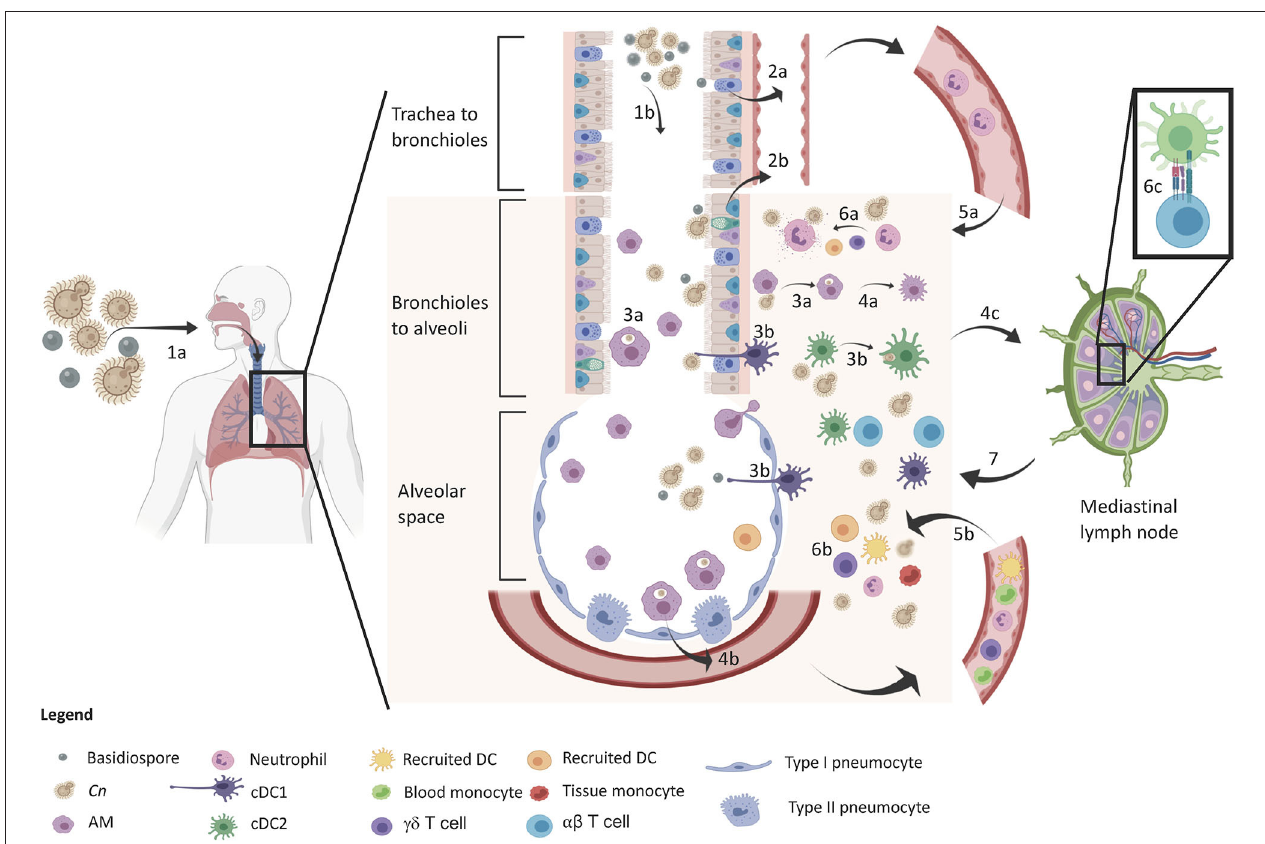
FIGURE 1 | Protective immune response in the lung upon inhalation of C. neoformans . The sequence of events is denoted in the diagram. The yeast and basidiospores are inhaled (1a) and travel down the airways passing through the trachea to the bronchioles (1b) and further down to the alveolar spaces. Upper respiratory epithelia sense the spores (2a) and lower respiratory epithelium sense spores and encapsulated propagules (2b), which release IL-8 for early neutrophil recruitment. Macrophages (3a) and DCs (3b) phagocytose Cn in both the airways and lung tissue leading to M1 macrophage polarization (4a) and cytokine release (GM-CSF and MCP-1) for inflammatory cell recruitment (4b). DCs mature and migrate to the lung draining lymph node (4c) for induction of adaptive immunity. At this time, neutrophil (5a) and inflammatory cells (5b) infiltrate into the lung tissue for increased host defense against Cn . Neutrophils kill Cn via degranulation (6a) and a myriad of other defenses from other cells (6b) such as monocyte differentiation into recruited DCs that further amplify T cell induction (6c). Type 1/17 polarized T cells migrate back to the lung for adaptive immune control of infection leading to control/containment of the